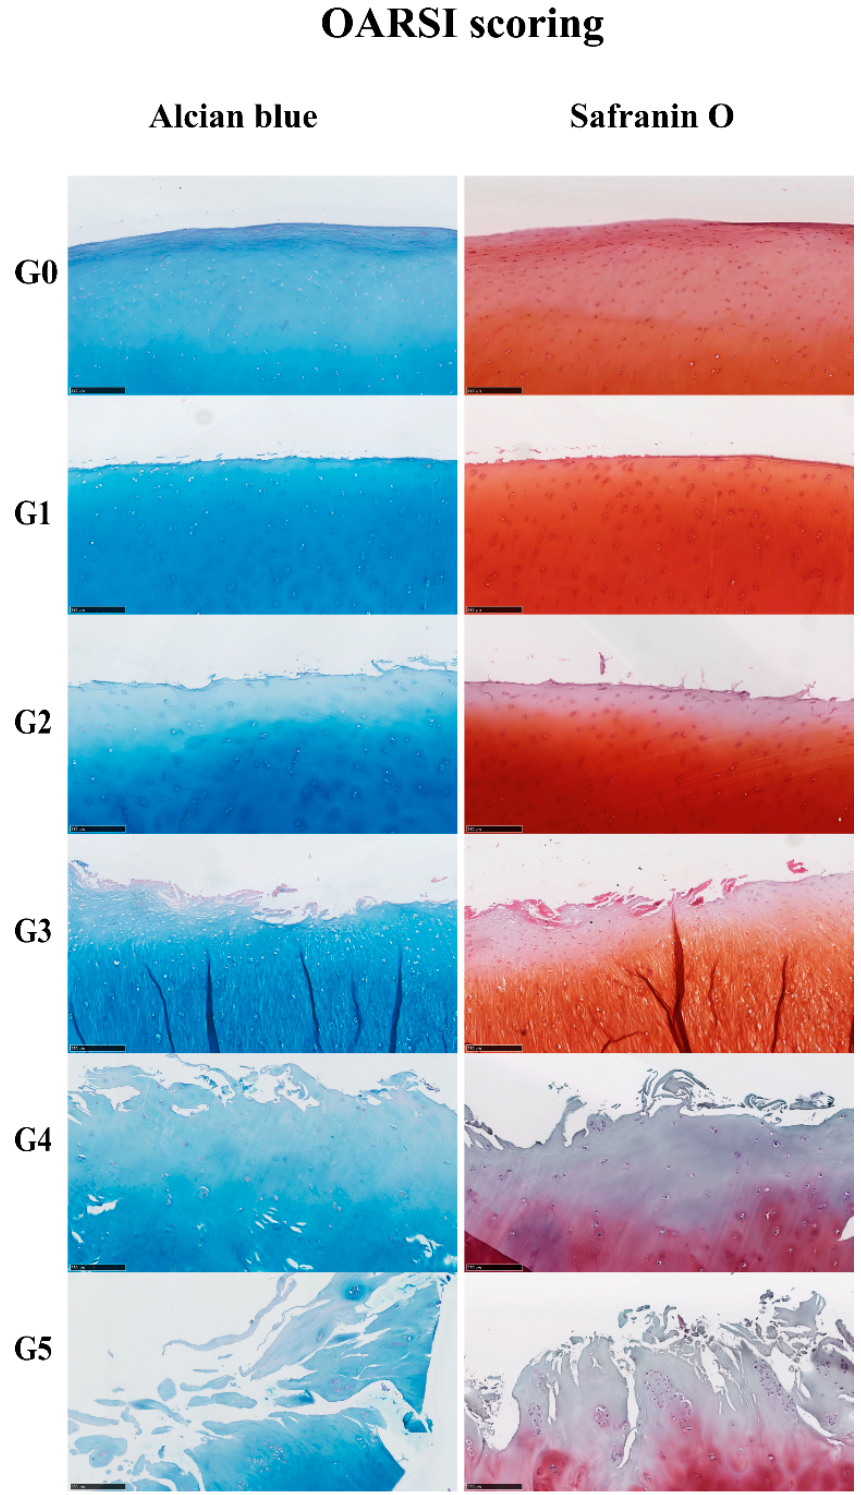
Figure 1. Histological changes of OA cartilage. Five micrometer paraffin sections of cartilage stained by Alcian blue and Safranin O (scale bar 250 µm). The severity of the OA lesion was graded on a scale of 0–5.